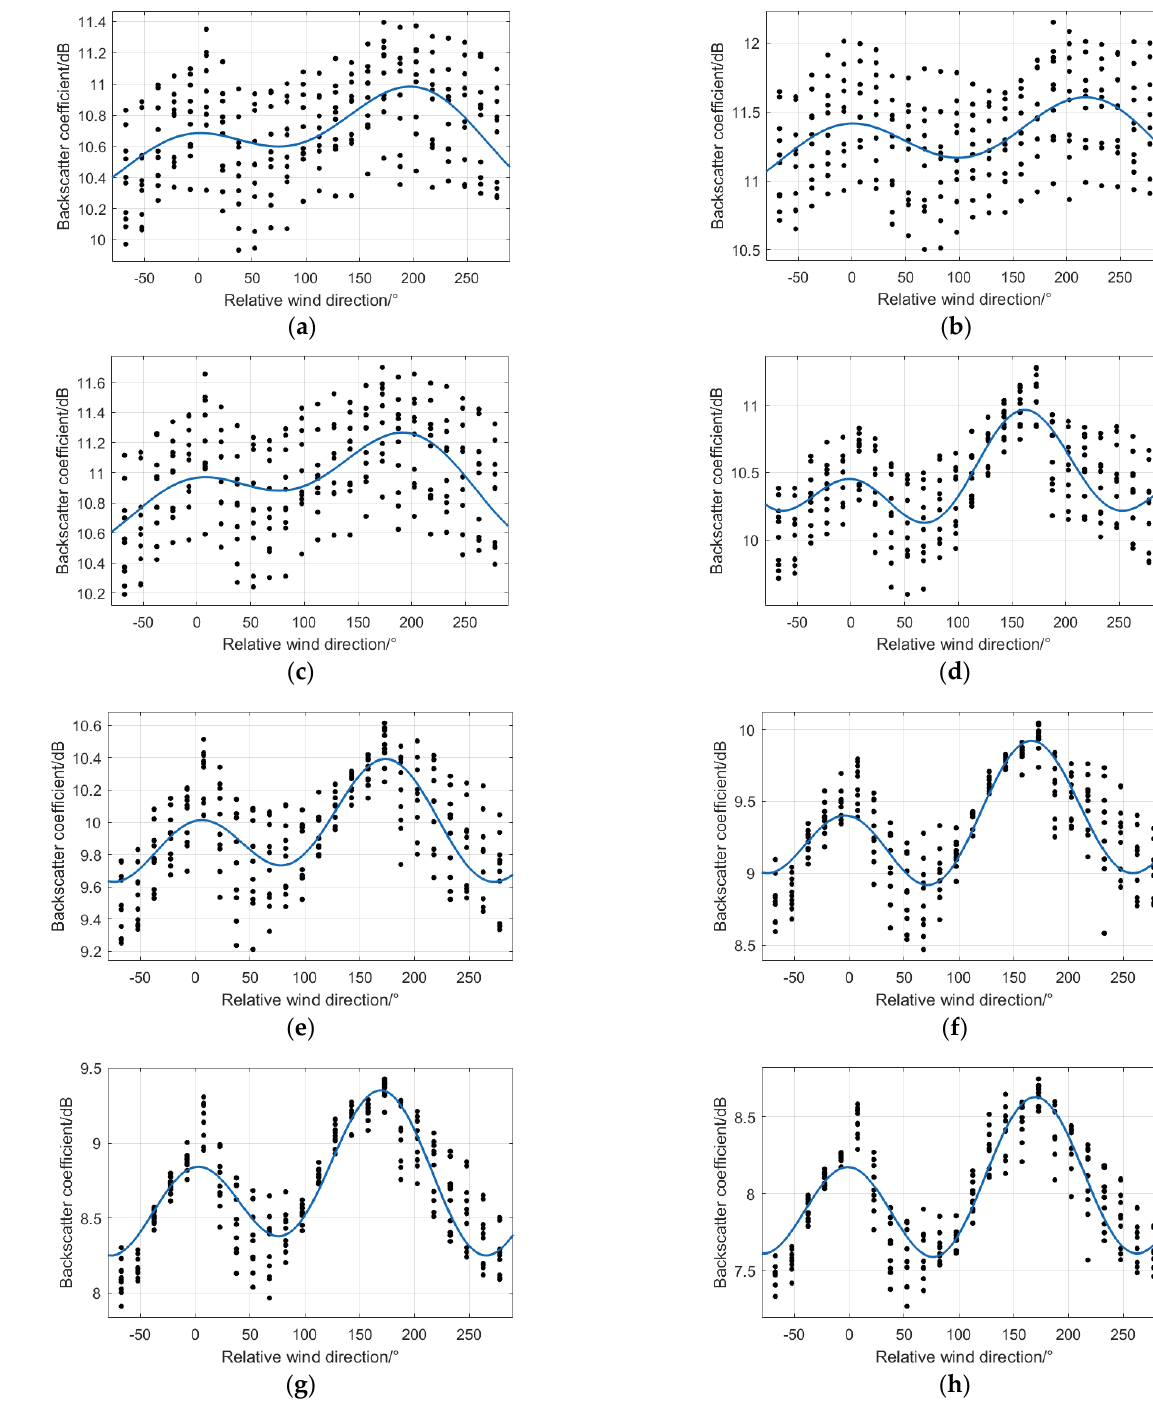
Figure 7. Azimuthal distribution at different incident angles: ( a ) 4°; ( b ) 5°; ( c ) 6°; ( d ) 7°, ( e ) 8°; ( f ) 9°; ( g ) 10°; ( h ) 11°.